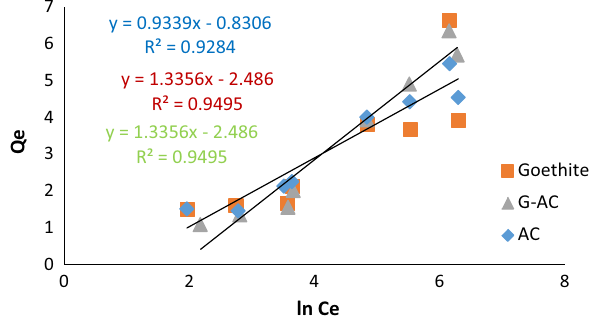
Fig. 11 Temkin isotherm plot Cr(VI) on G, AC and GAC